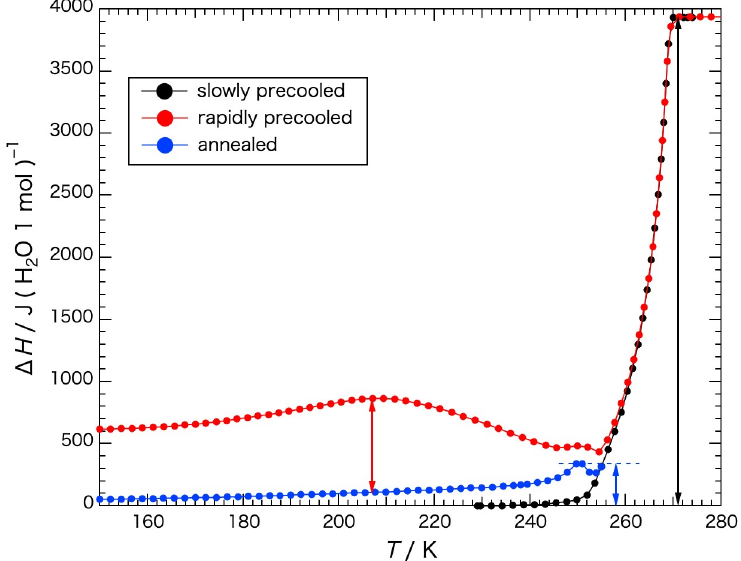
Figure 7. Fusion enthalpy of the water within the slowly precooled gel ( • ) and the crystallization enthalpy of the water during rewarming observed with the rapidly precooled gel ( • ) and the annealed gel ( • ). A red two − directional arrow indicates the crystallization enthalpy in the low subzero- temperature region, and a blue two-directional arrow indicates the crystallization enthalpy in the high subzero-temperature region.